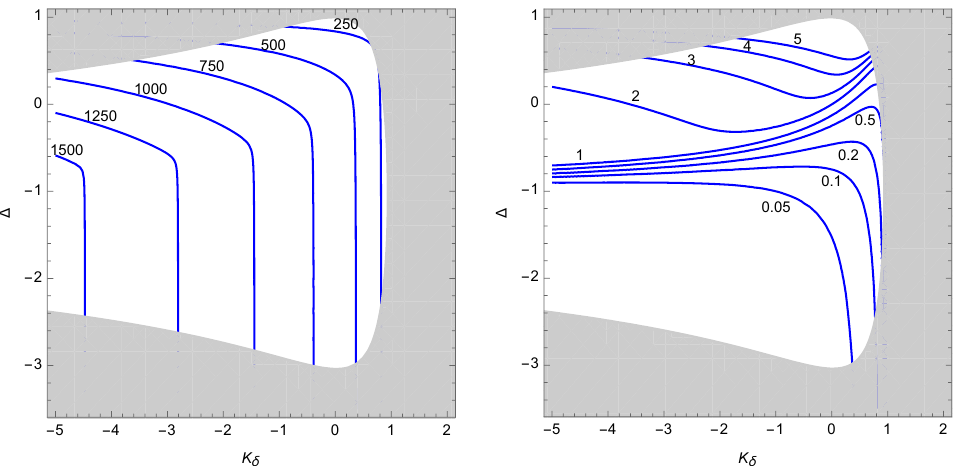
Figure 2 . Contours, as a function of (cid:1) and K (cid:14) , of the mass of the Dark Matter candidate (left) and the mass splitting with the nearby charged scalar (right). All values are in GeV, and we (cid:12)xed p C g = 1 = 3 C t and (cid:18) = 0 : 2 (i.e. 2 2 f = 1 : 2 TeV). The grey area is theoretically